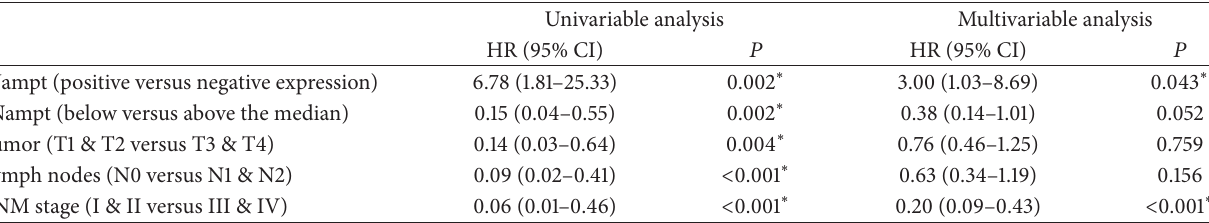
Table 4: Cox regression analysis of factors associated with death from